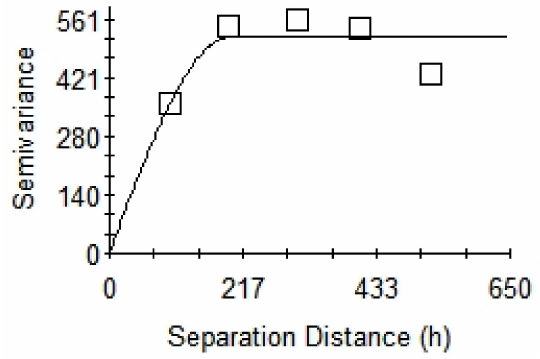
Figure 5. Semivariogram for AWHC data at FGVAS Serting Hilir